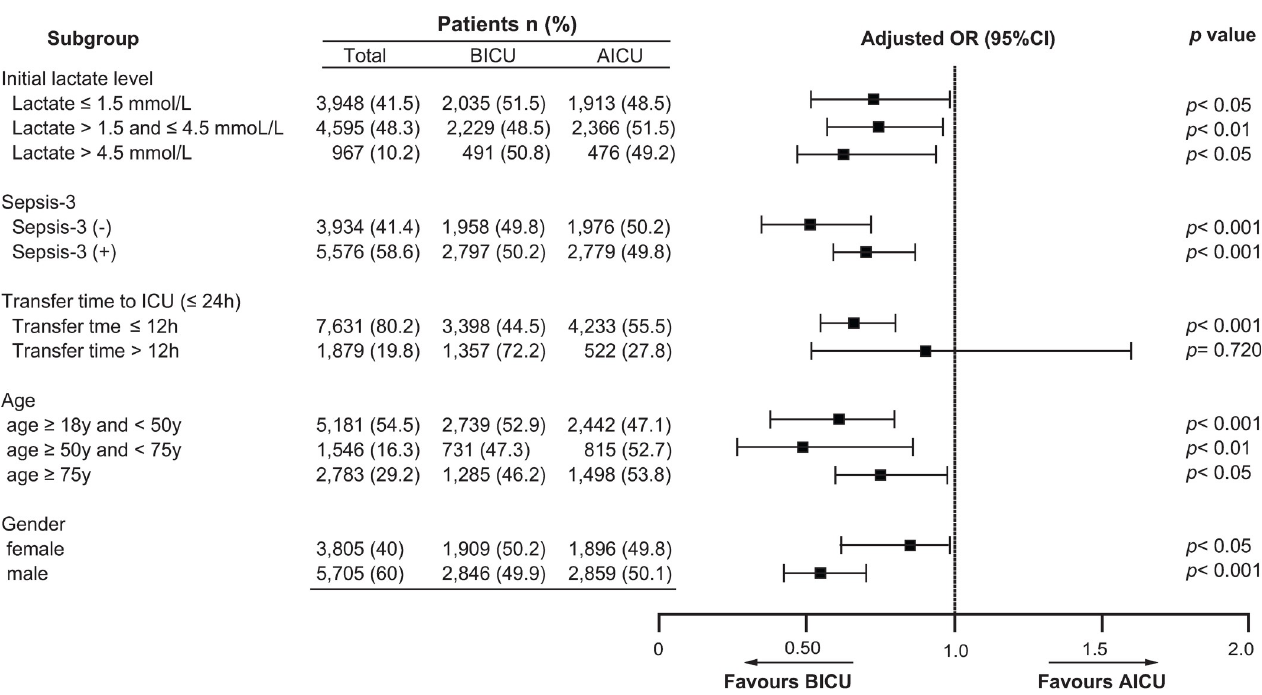
PLOS ONE | https://doi.org/10.1371/journal.pone.0277948 November28,